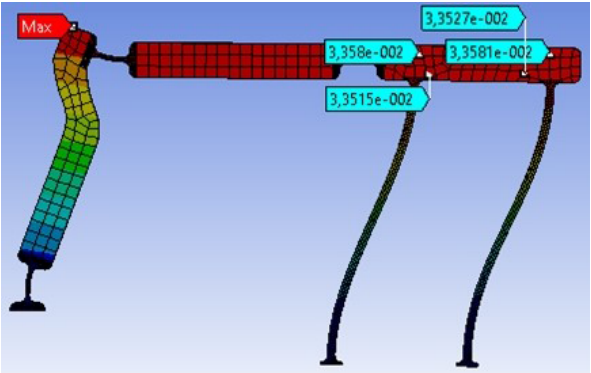
Figure 10. Stroke analyses for fully compliant slider-crank mecha- nism.